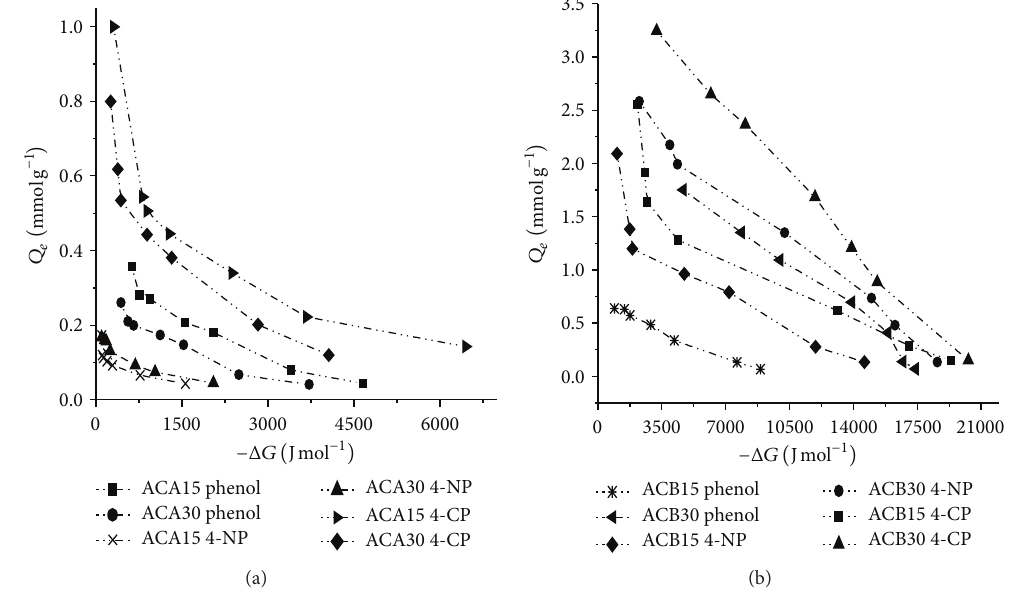
Figure 7: Adsorbed amount of phenols in function of the change in free energy on ACs at 20 ∘ C.